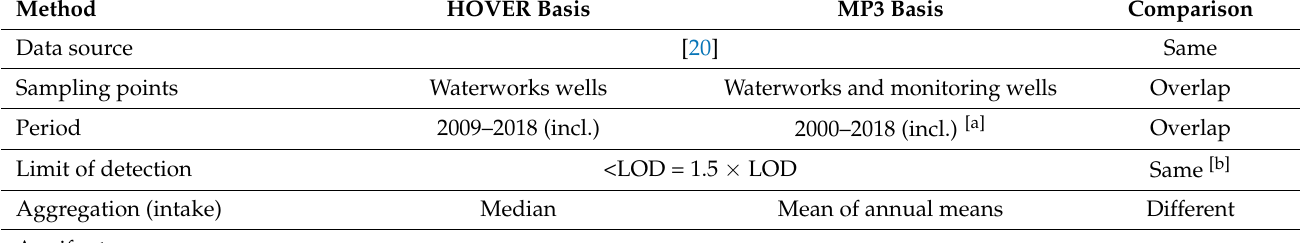
Table 2. Methodology comparison for NBL assessment based on the HOVER and MP3. HOVER Basis MP3 Basis